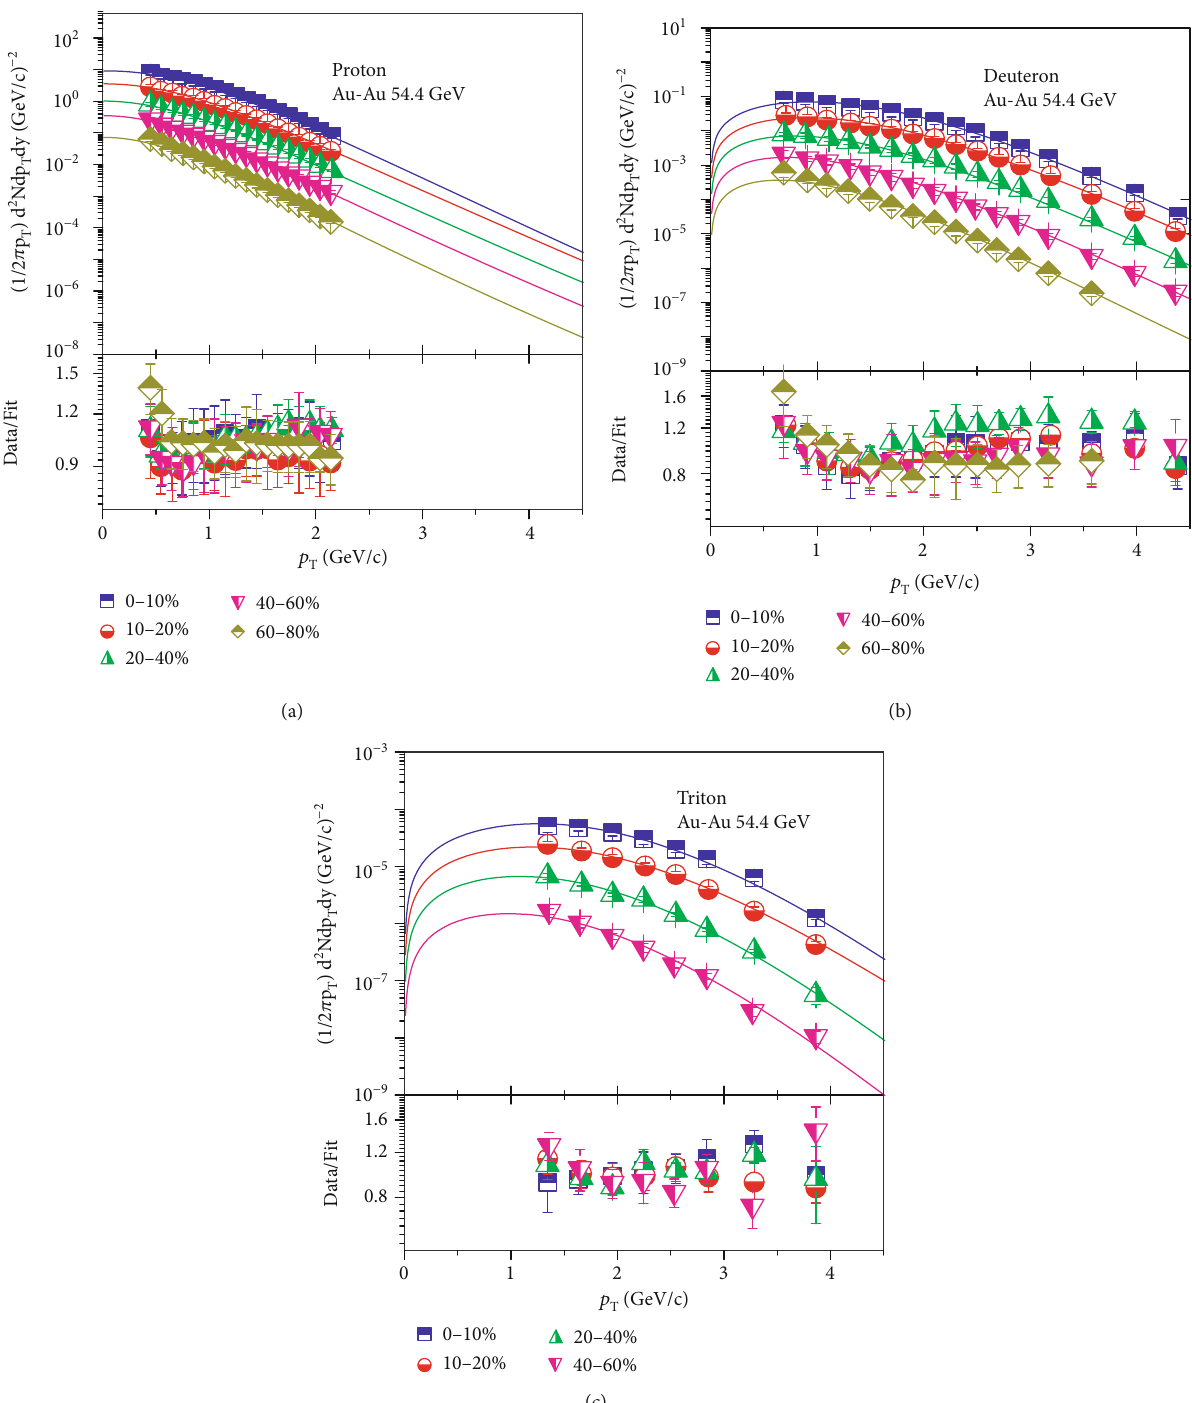
ffiffiffiffiffiffiffiffiffiffi p = 54 : 4 GeV. The sNN